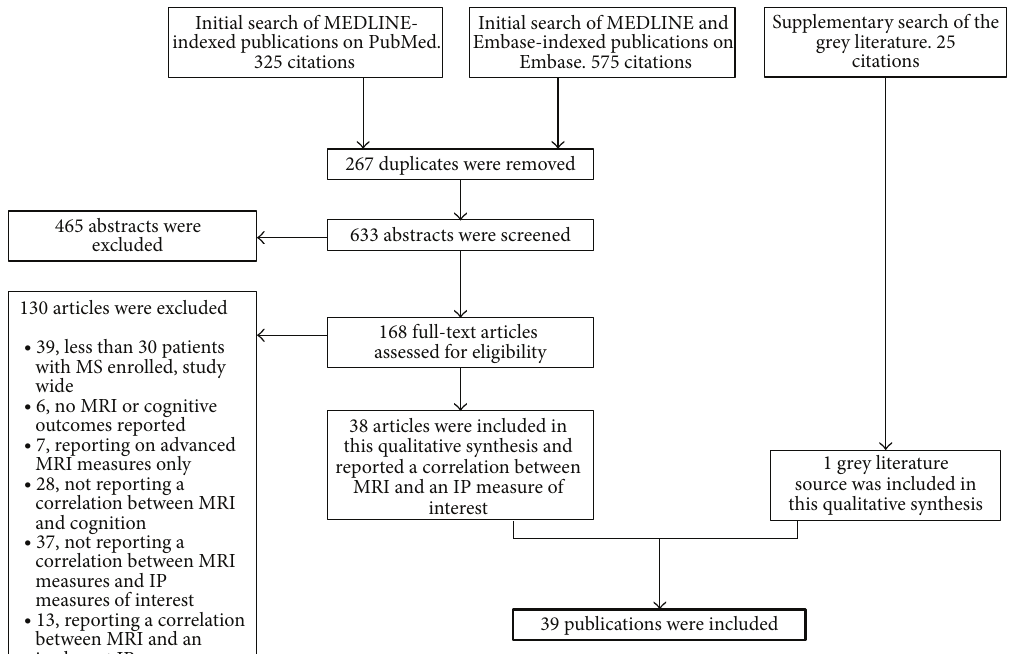
Figure 1: Flow chart for identification of studies in the systematic review.